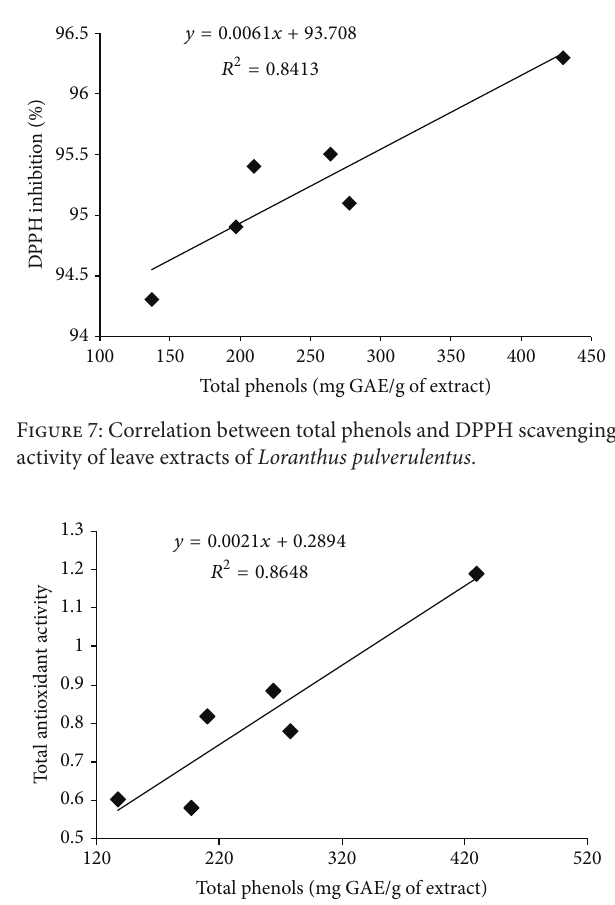
Figure 11: Correlation between total phenols and total antioxidant activity of seed extracts of Loranthus pulverulentus